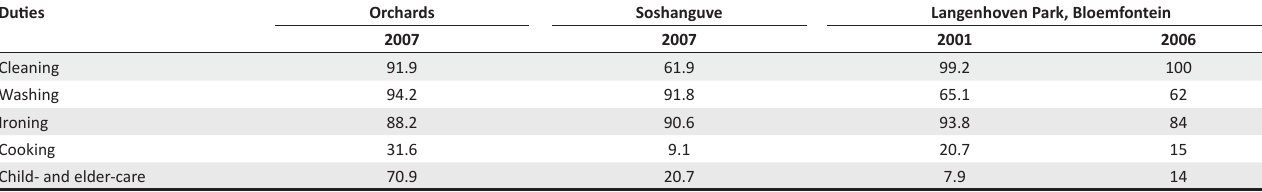
TABLE 3: Average hours that domestic workers worked per day in Orchards and Soshanguve in 2007. Area Number of respondents